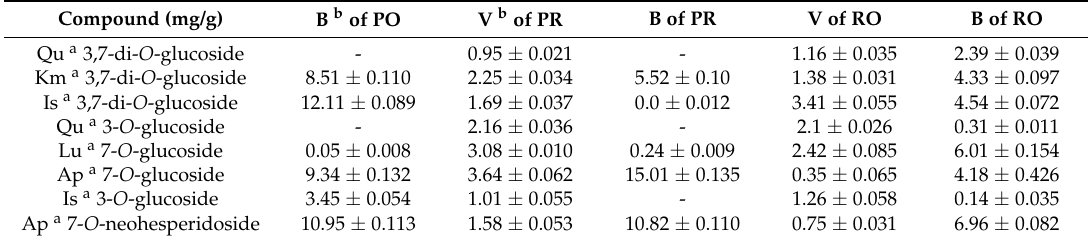
Table 3. The contents of glycosides of flavone and flavonol in the backgroud and variegation of materials at fully open